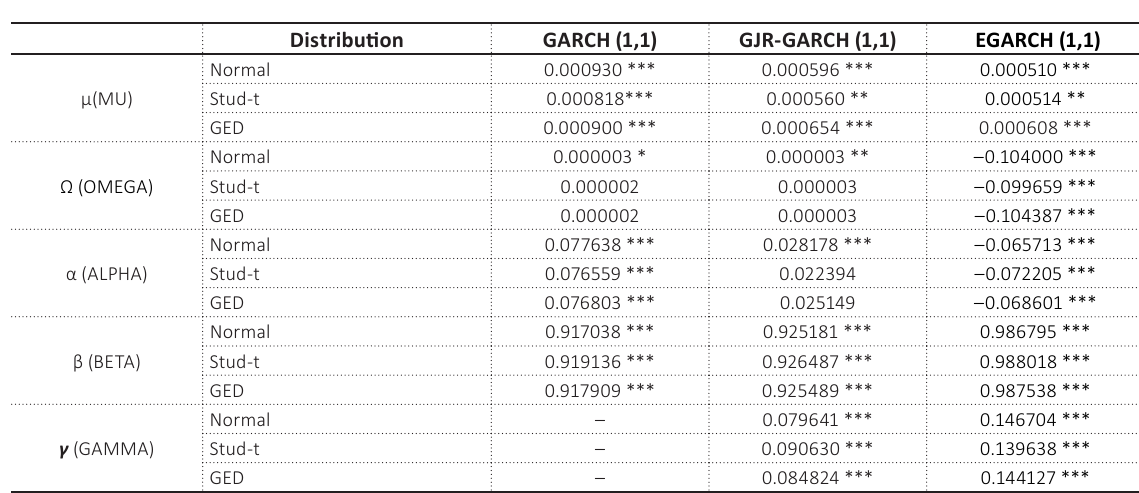
Table 4. Estimation of results using GARCH